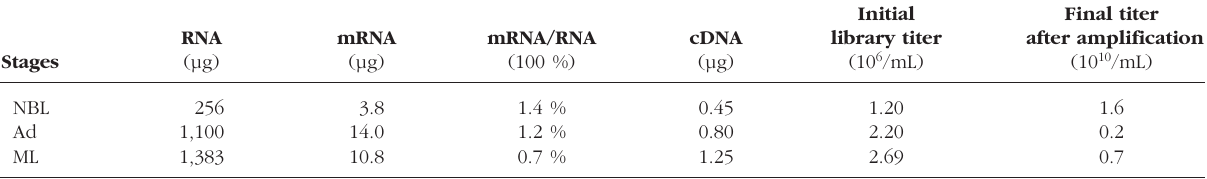
Table I. – Characteristics of the various cDNA libraries obtained from the three main antigenic stages of Trichinella spiralis , ISS534.